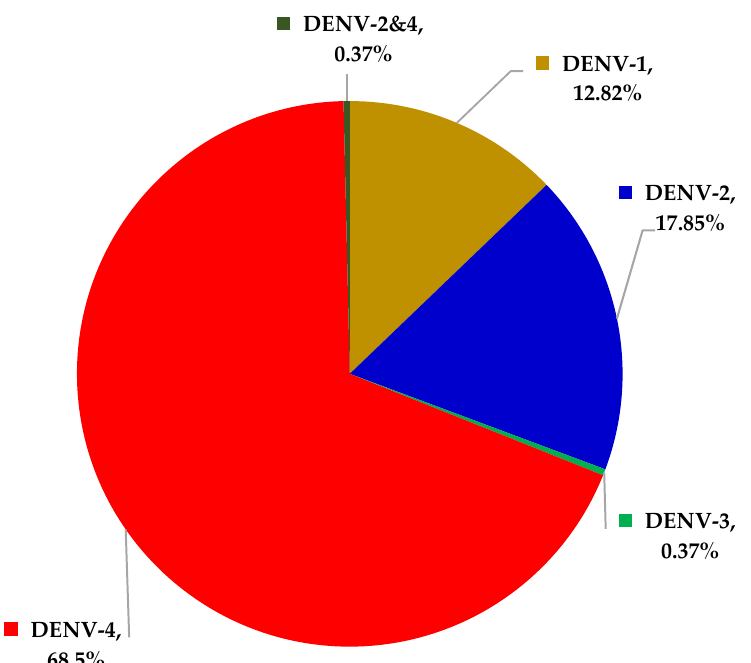
Figure 1. Percentages of DENV serotypes among 273 patients who tested positive for DENV by RT-rPCR. Table 1. Results of qPCR assay and NS1 tests in the overall 488